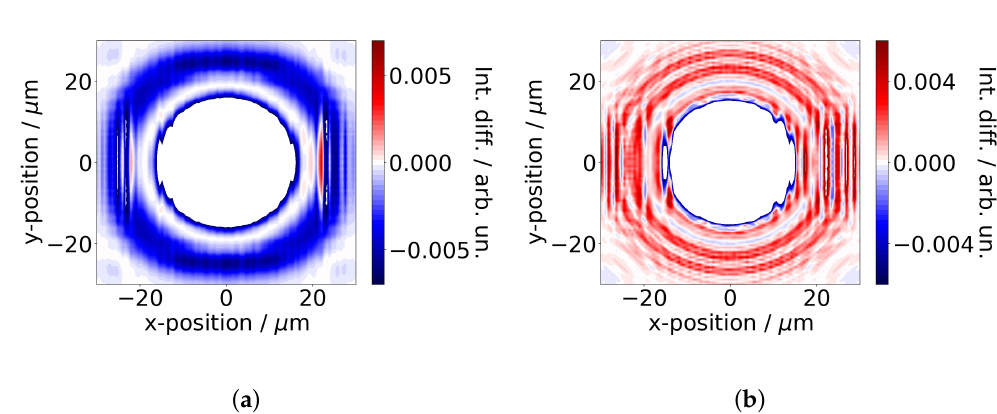
Figure 6. Structure-induced intensity changes to the far-field distribution at 50 µ m distance, that is, the difference between the far-field distribution of reflected light from structured and unstructured samples. ( a ) For an entirely structured sample surface. ( b ) For a sample where only the central spot (30 µ m diameter) is